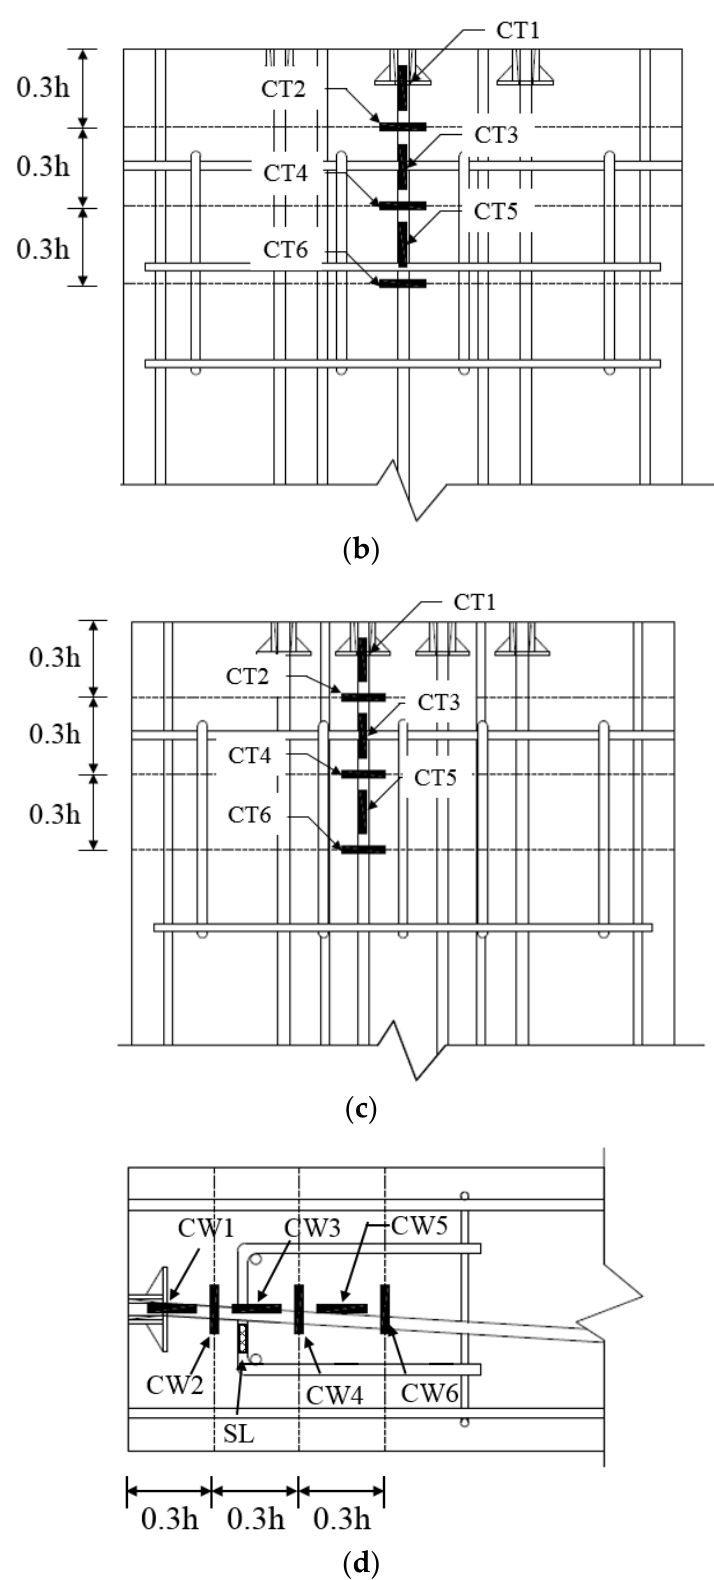
Figure 4. Locations of gauges: ( a ) specimens with two anchorages; ( b ) specimens with three anchorages; ( c ) specimens with four anchorages; ( d ) side view of specimens.